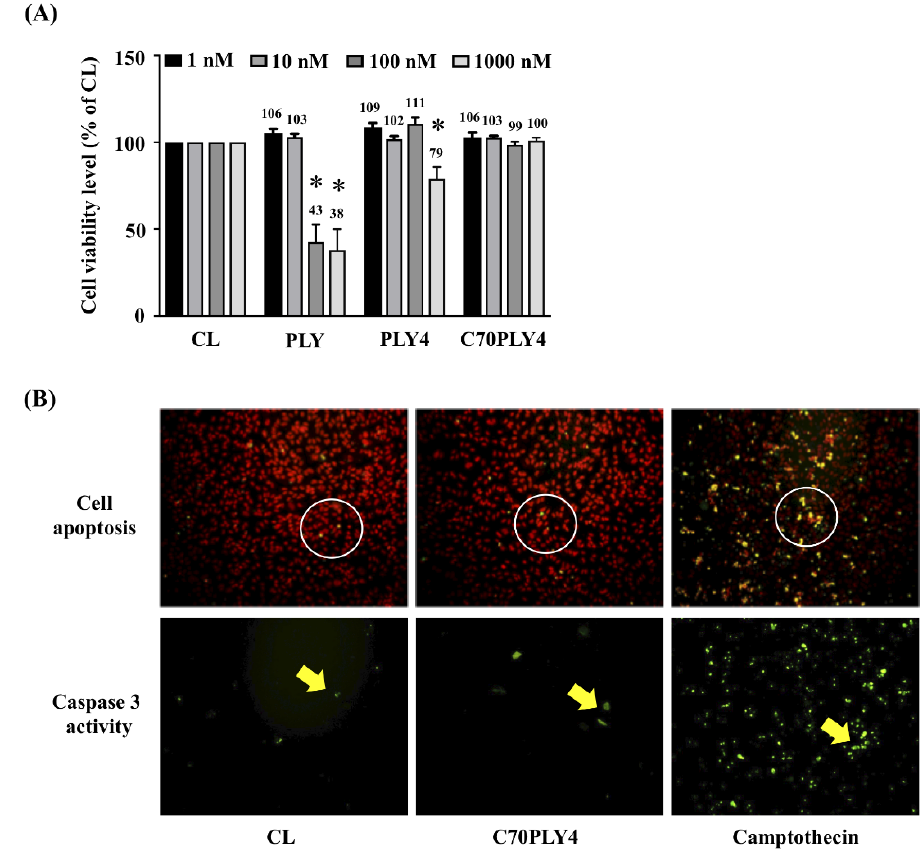
Figure 7. C70PLY4 does not affect the viability, apoptosis, or caspase 3 activity in human umbilical vascular endothelial cells (HUVECs). ( A ) Cells were kept untreated as a control or treated with PLY, PLY4, or C70PLY4 at a concentration of 1, 10, 100, or 1000 nM for 18 h, and the cell viability was detected by an MTS assay. ( B ) Cell apoptosis and caspase 3 activity were also detected in HUVECs under C70PLY4 treatment. Cells were kept untreated as a control or treated with C70PLY4 (100 nM) or camptothecin for 18 h, and the cell apoptosis (upper panel) and caspase 3 activity (lower panel) in the HUVECs were detected. Data in ( A ) are the mean ± SEM from three independent experiments. *, p < 0.05 vs. control cells.